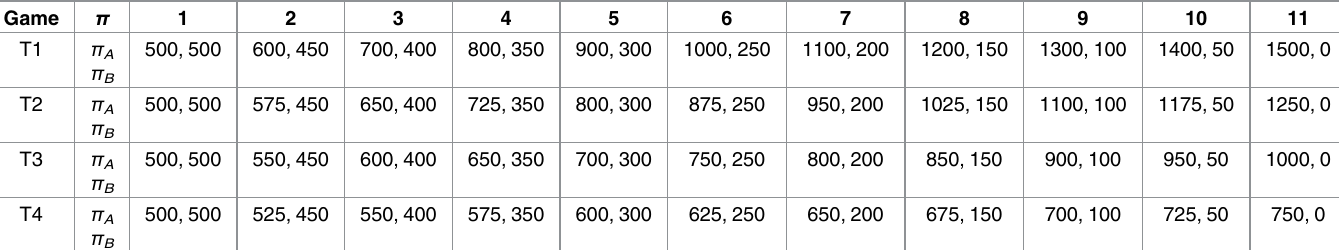
Table 1. Payoffs in the four take games.